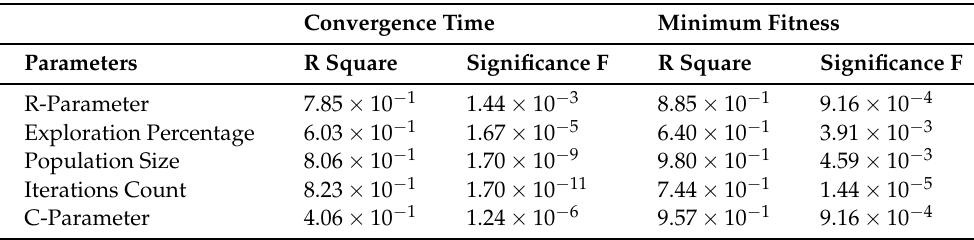
Table 17. Results of regression analysis for the GSDTO’s parameters.